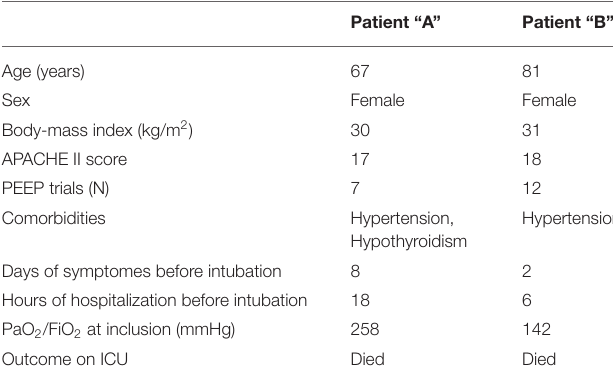
TABLE 1 | Patient